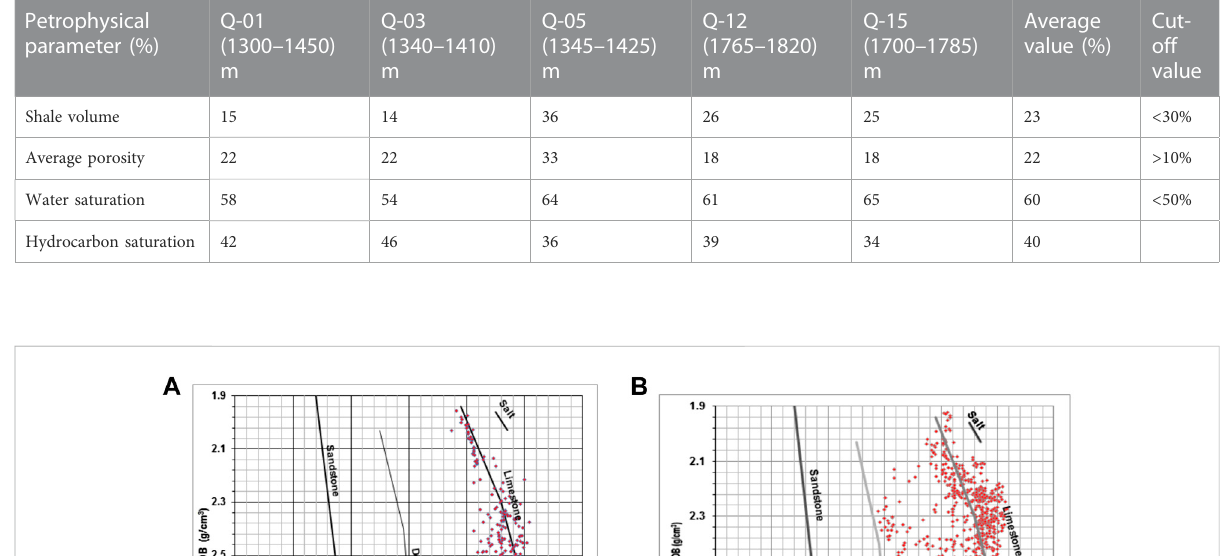
TABLE 1 Quantitative petrophysical interpretation of the Sui Main Limestone reservoir in the Q-01, Q-03, Q-05, Q-12 and Q-15 wells drilled in the study area.